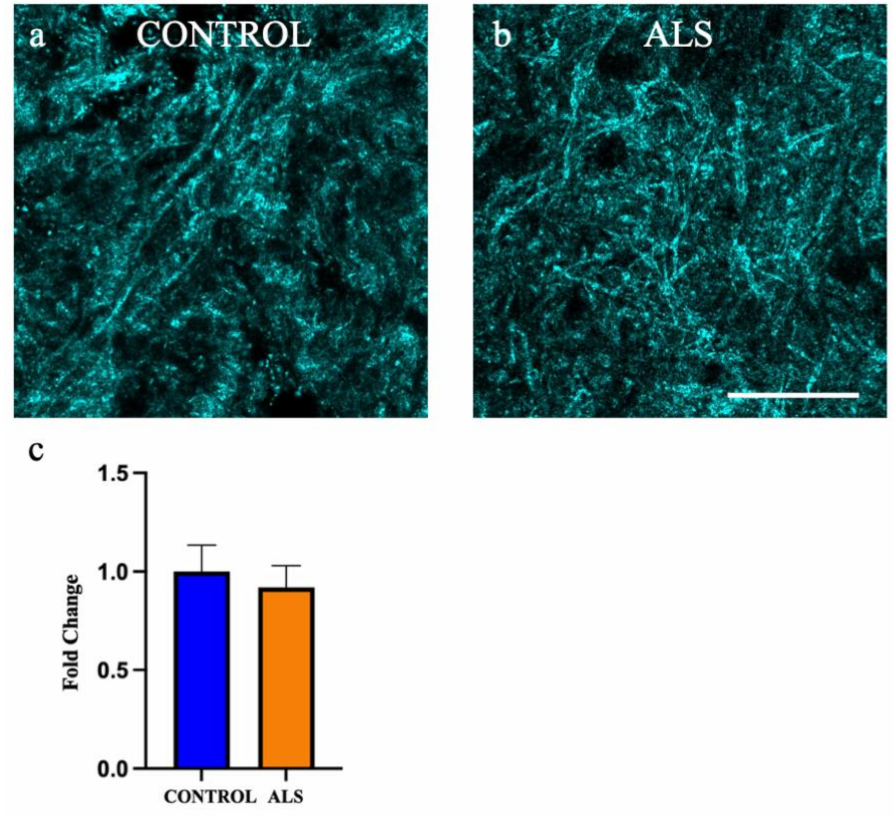
Figure 8. Myelin density is not altered in the white matter of the motor cortex in ALS. Representative images of the white matter of the motor cortex taken using spectral reflectance microscopy (SCoRe) in the ( a ) control and ( b ) sALS case. ( c ) there was no difference in the amount of myelin in the white matter of the motor cortex in ALS (sALS n = 8; orange) when presented as a fold change from control (n = 8; blue). Scale bar 25 µ